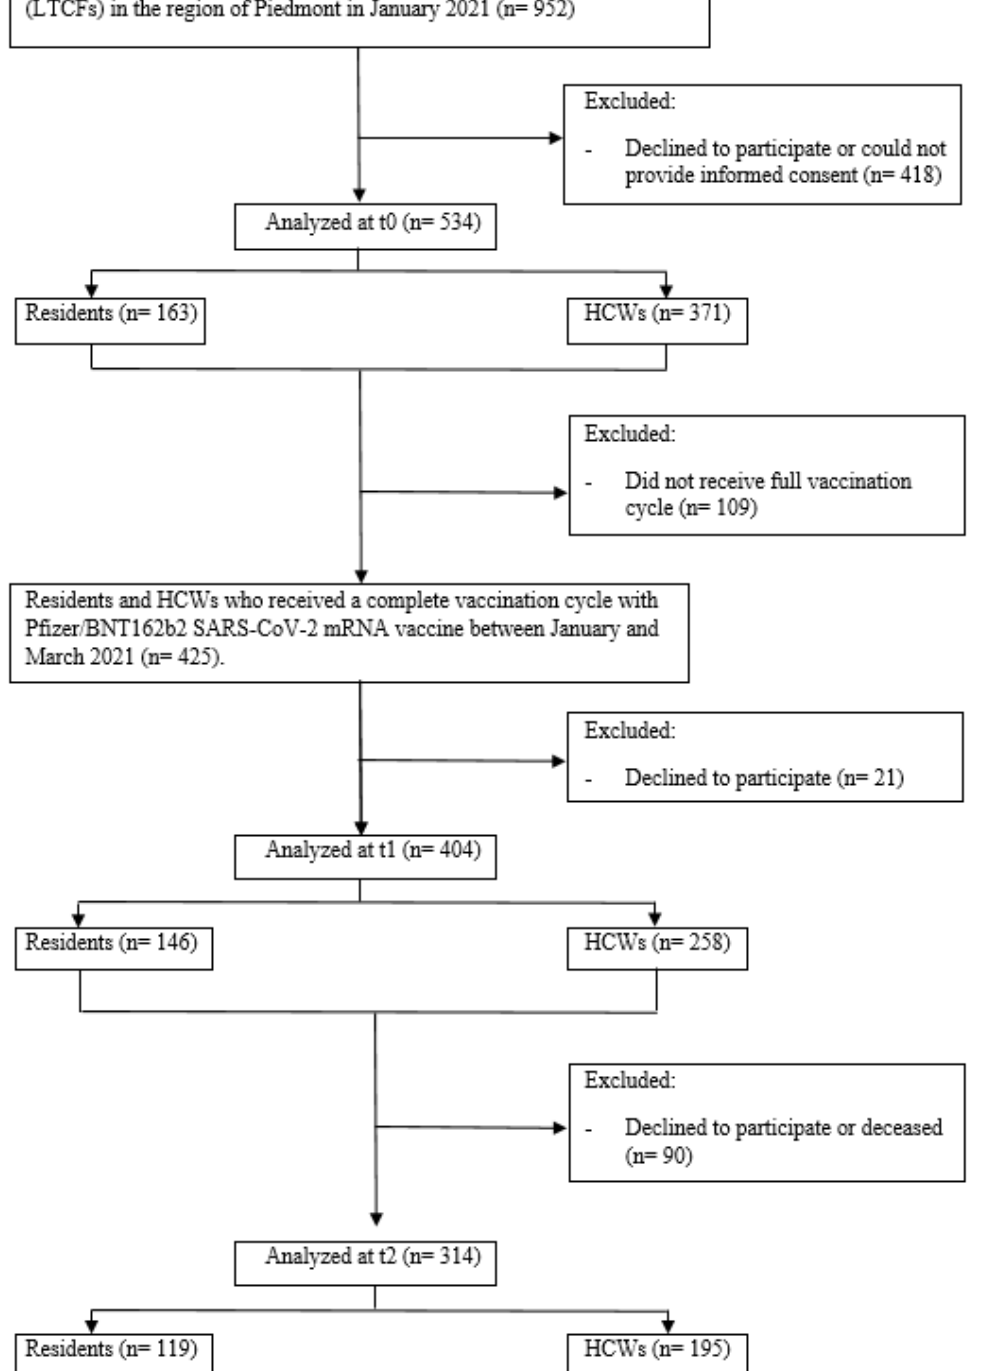
Figure 1. Study flow chart. HCWs: healthcare workers; LTCF: long-term care facility; t0: time period prior to vaccination; t1: two weeks after after completing the vaccination cycle; t2: 9 months after completing the vaccination cycle.